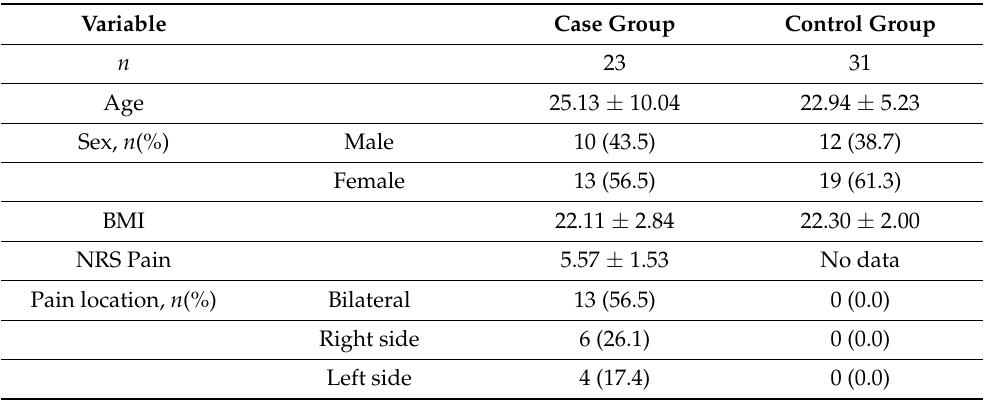
Table 2. Demographic characteristics of subjects. Data are reported ad the mean ± standard deviation or with absolute and relative values (%).